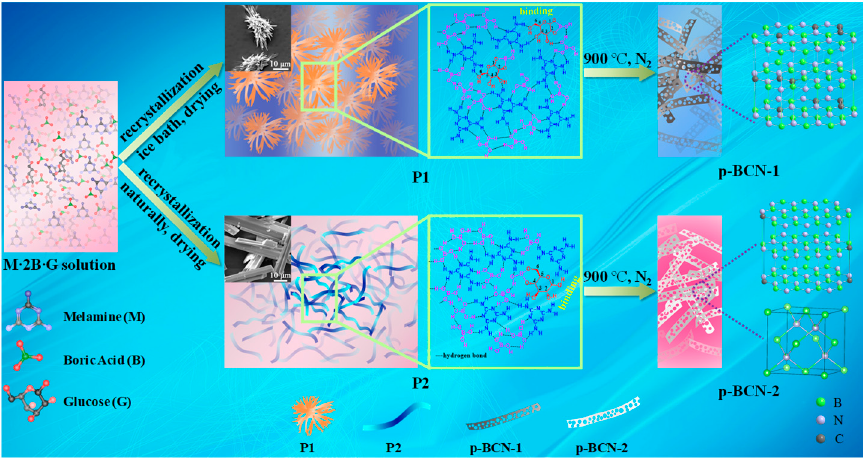
Figure 15. Schematic synthesis of p-BCN-1 and p-BCN-2 samples.